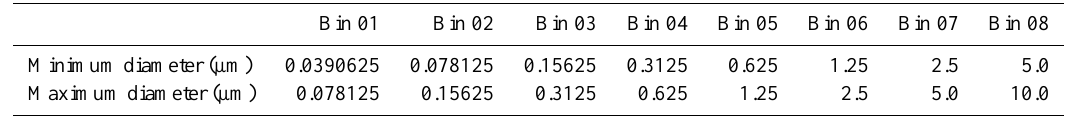
Table 1. Sectional approach for aerosols: particle dry-diameter ranges used in this study.